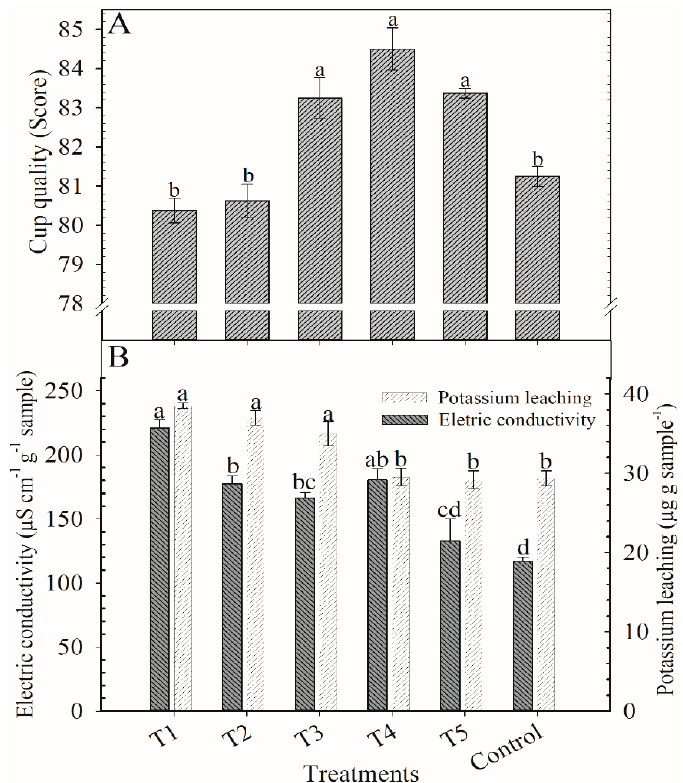
Figure 7. Scores of cup quality ( A ), electric conductivity and potassium leaching ( B ) in coffee beans at cherry stage after application of blends of KCl e K 2 SO 4 as cover fertilization. Harvest of 2018/2019. Means followed by the same letter in the column do not differ according to Tukey’s test ( p < 0.05). Vertical bars indicate the standard error of the mean ( n = 4). T1: 100% KCl; T2: 75% KCl + 25% K 2 SO 4 ;